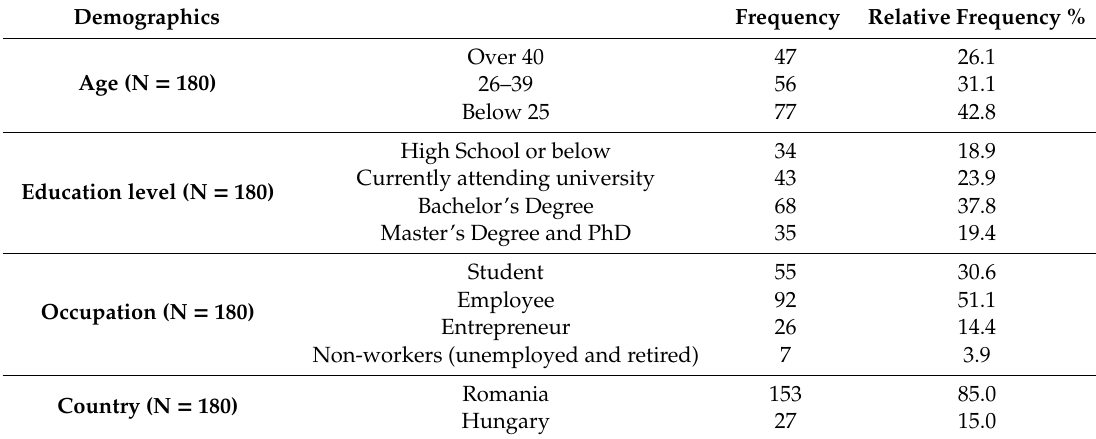
Table 1. Demographic characteristics of the